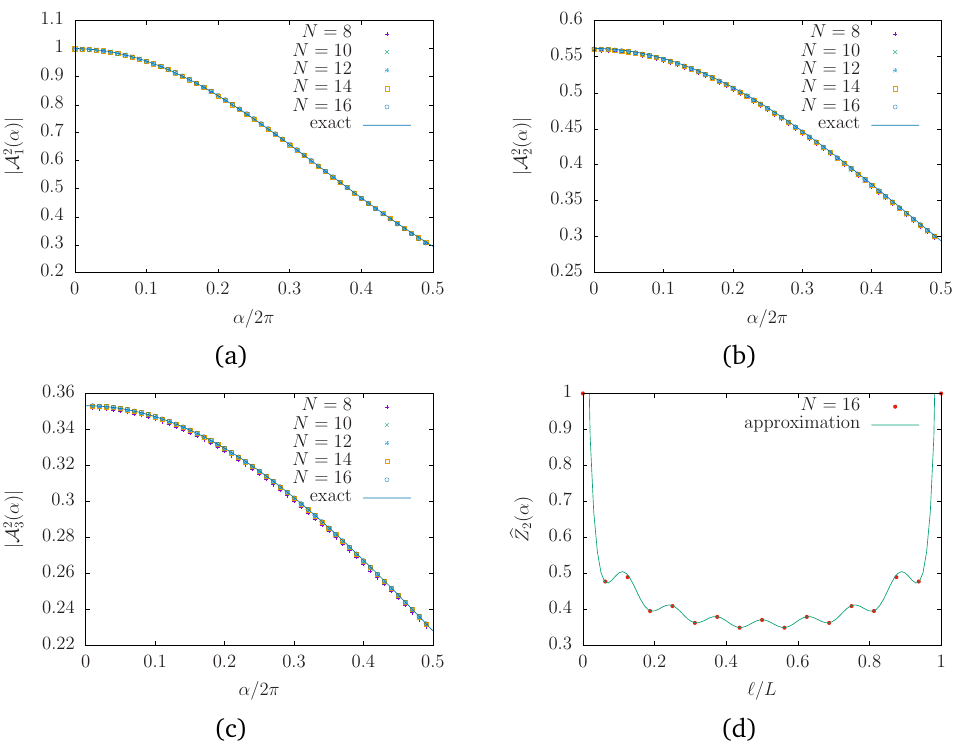
( α ) and ( α ) for the periodic XX chain. (a,b,c) The pref- Figure 3: The functions (cid:98) Z n A n ( α ) | 2 , obtained from the numerical computation of the two-point function actors | A n 〈 t † t α 〉 for n = 1,2,3 on a cylinder, are compared with the exact formula (3.63). α t α 〉 for n = 2 and N = 16 is plotted (d) The numerical two-point function 〈 t † α ( α ) | 2 taken from the exact against the approximation (3.74), with coefficients | A 2 formula